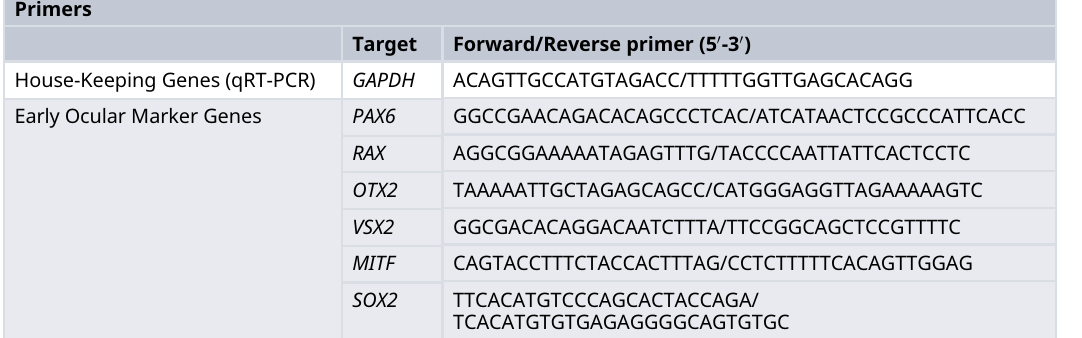
Table 1. qRT-PCR primers used in optic vesicle